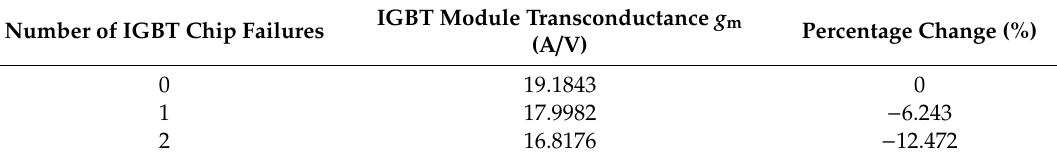
Figure 6. Transmission characteristic curves of IGBT modules under chip failure states. Table 2. Transconductance of IGBT modules under chip failure